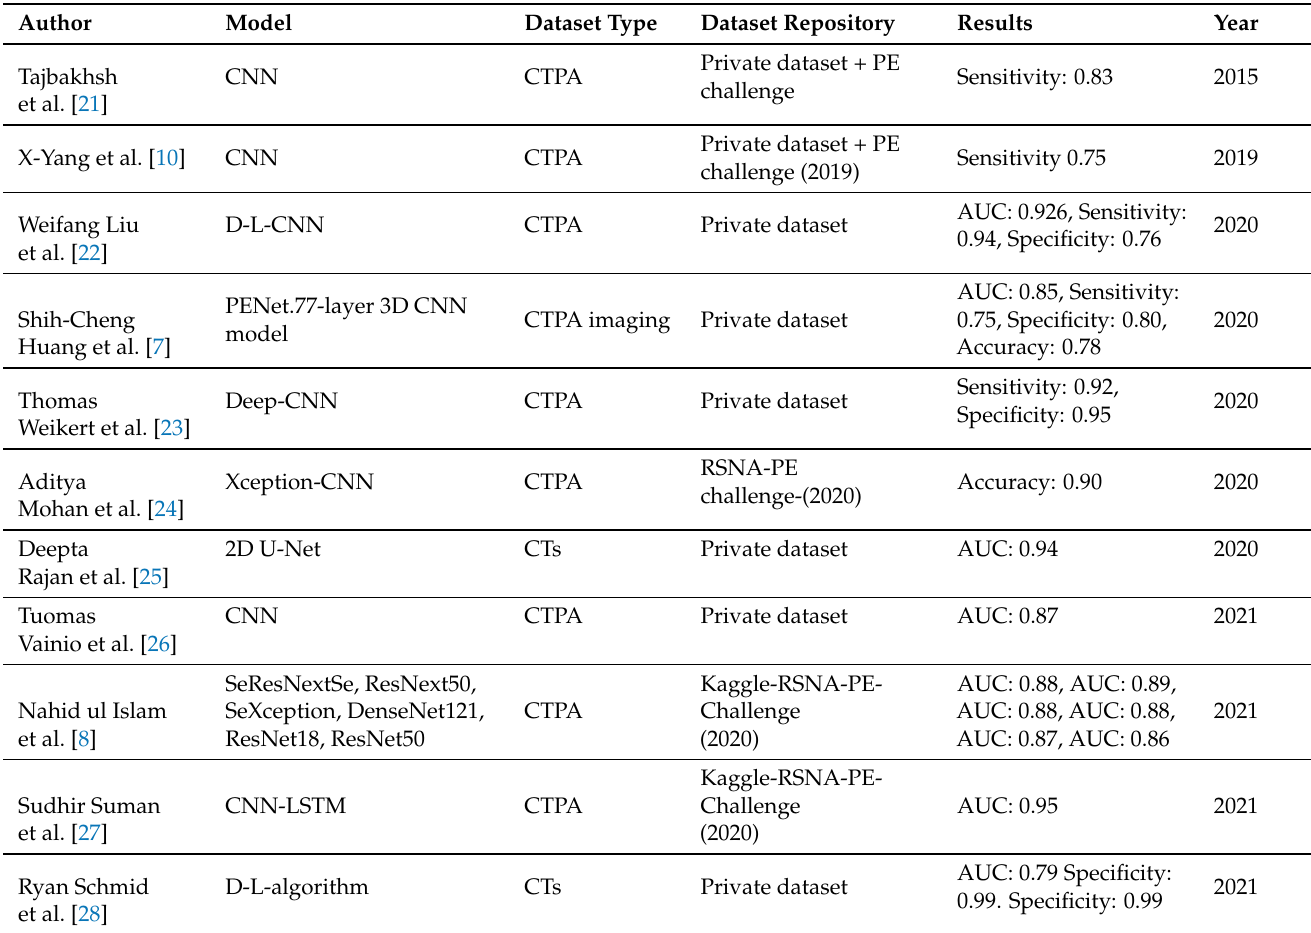
Table 1. Overview of state of the